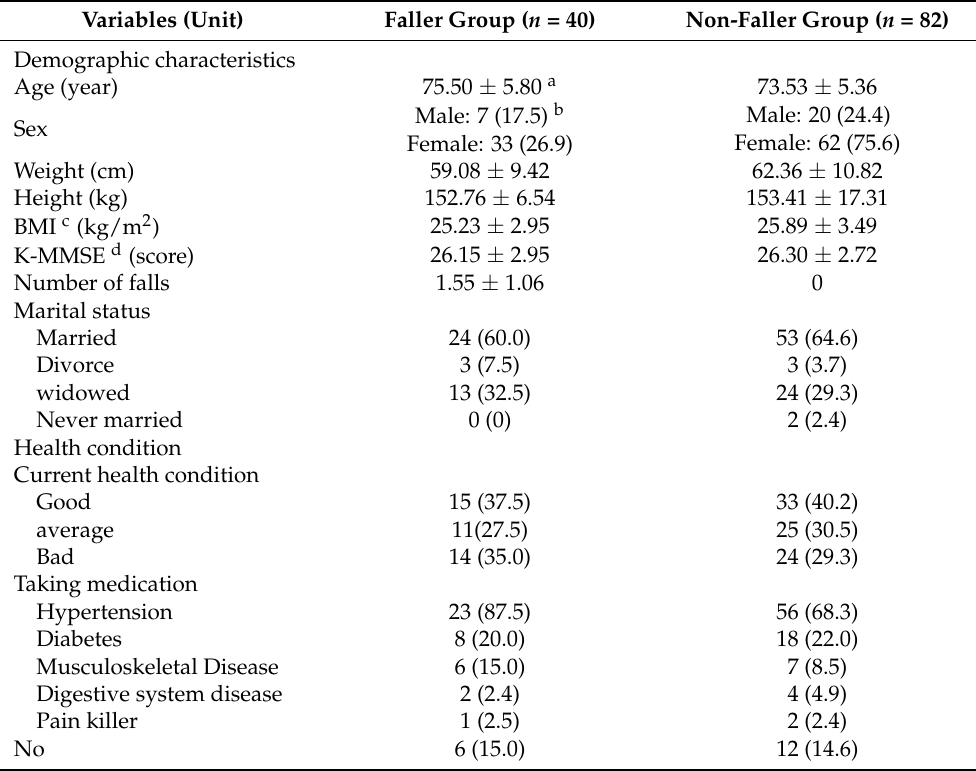
Table 1. Demographic characteristics and health condition of the participants .